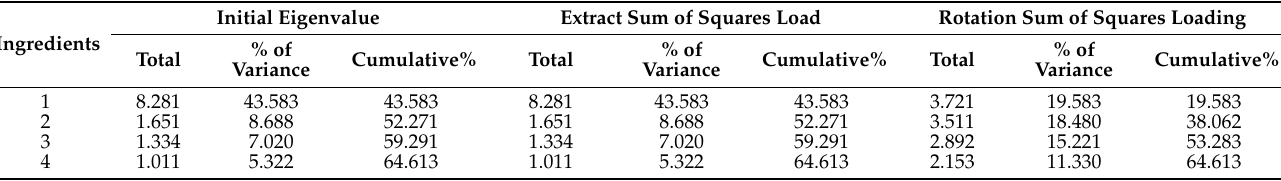
Table 3. Total variance of factor